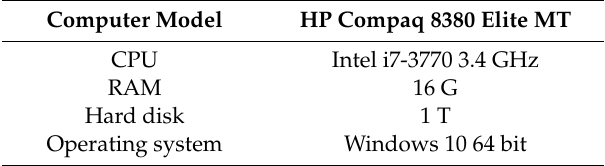
Table 2. Hardware environment configuration of experimental platform.